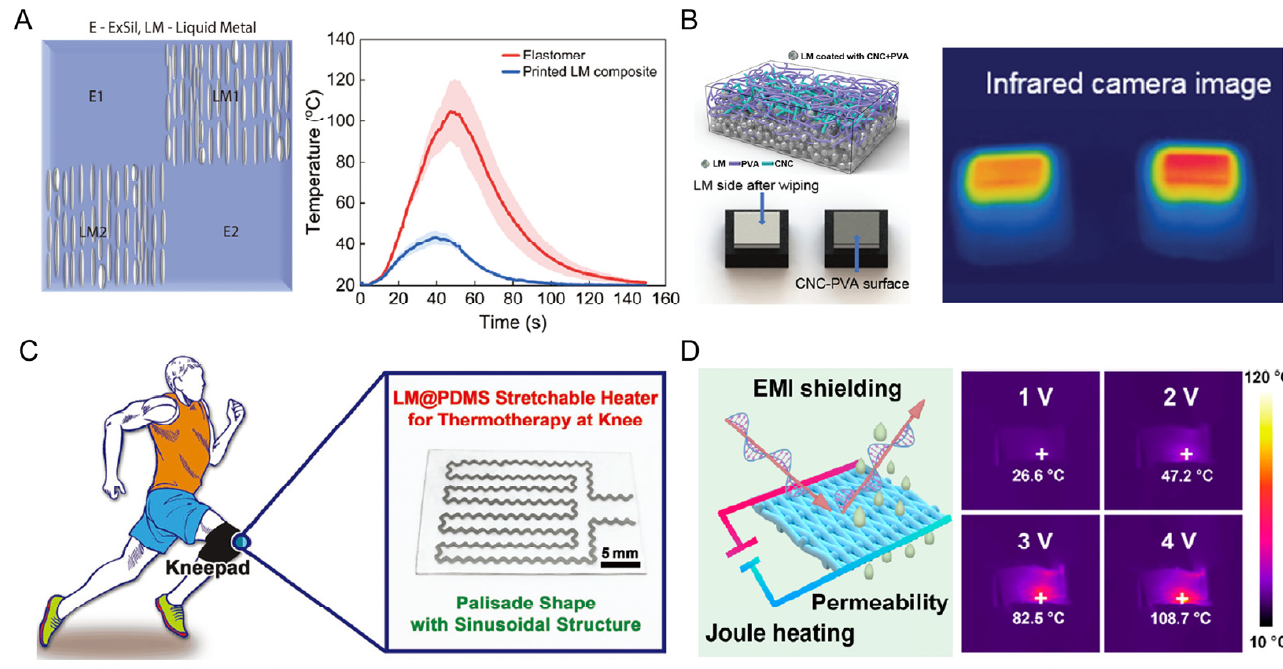
Figure 13. The LM-based electronics for epidermal thermal management. ( A ) Schematic of the multilateral printed heat sink with four regions ( left ), and the temperature of the LEDs on four regions ( right ) [41]. Copyright: (2022) WILEY-VCH. ( B ) Schematic of the LM-based Janus film for thermal management ( left ), and the infrared image of their thermal management [114]. Copyright: (2019) The Royal Society of Chemistry. ( C ) Schematic of the LM@PDMS heater in a palisade shape for articulatio genus thermal treatment [81]. Copyright: (2019) WILEY-VCH. ( D ) Schematic illustration of the electromagnetic interference shielding and joule heating ( left ). The joule heating performances of the device under different voltages [116]. Copyright: (2020) American Chemical